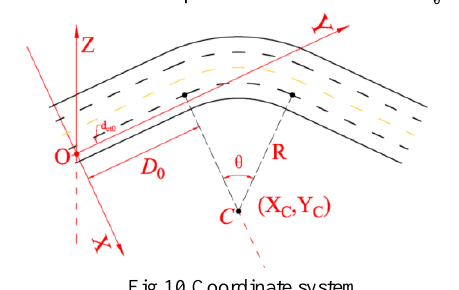
Fig.10 Coordinate